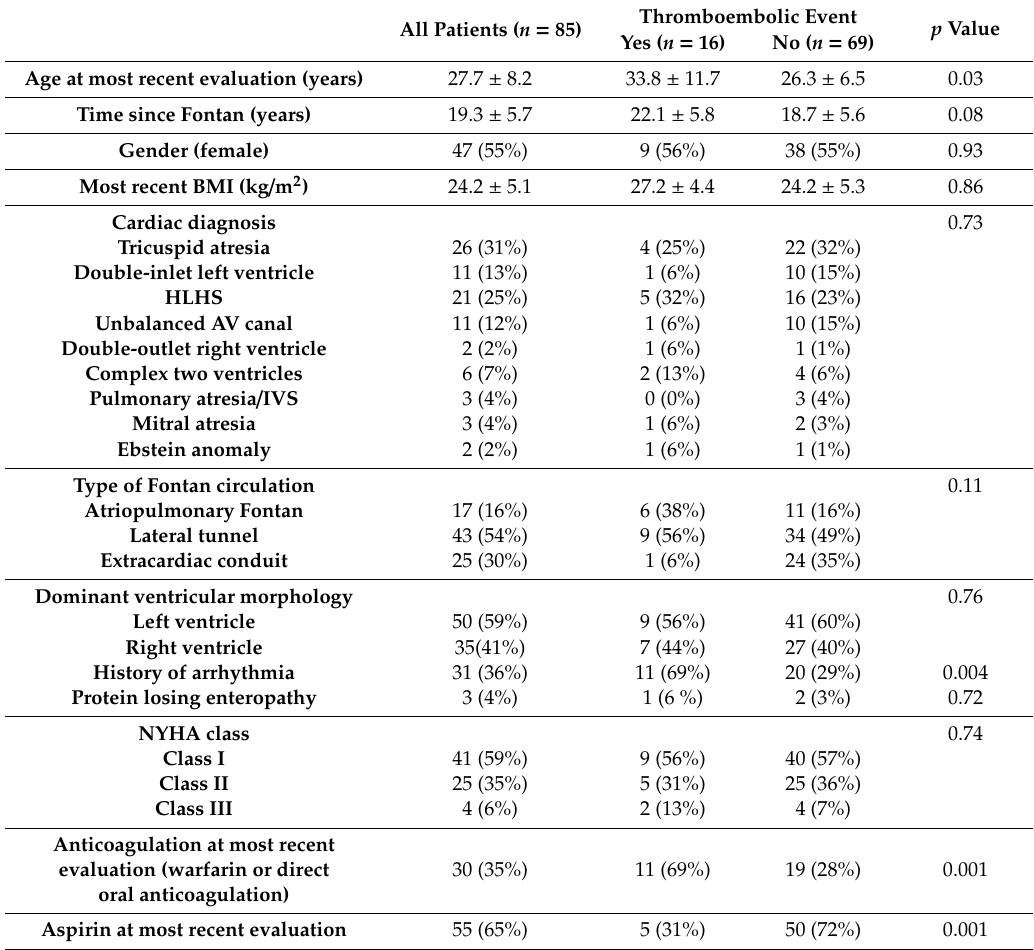
Table 1. Demographic and clinical characteristics of the study